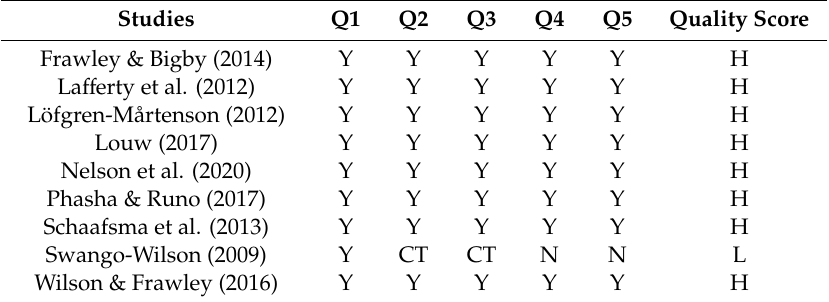
Table 1. Methodological quality of qualitative studies using MMAT (Hong et al., 2018).